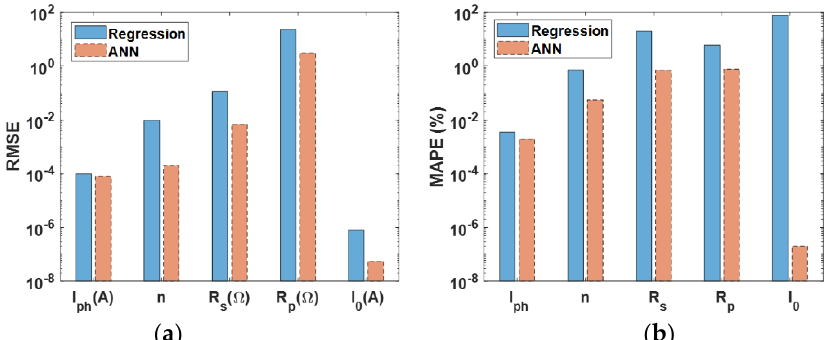
Figure 4. Statistical metrics for the five parameters in evaluating the accuracy of the regression model and ANN model: ( a ) RMSE and ( b )